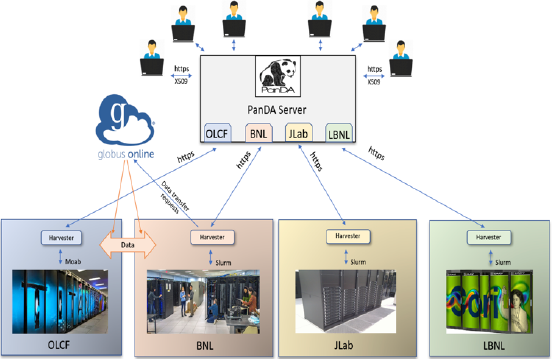
Figure 3: 2-point Statistics Analysis workflow